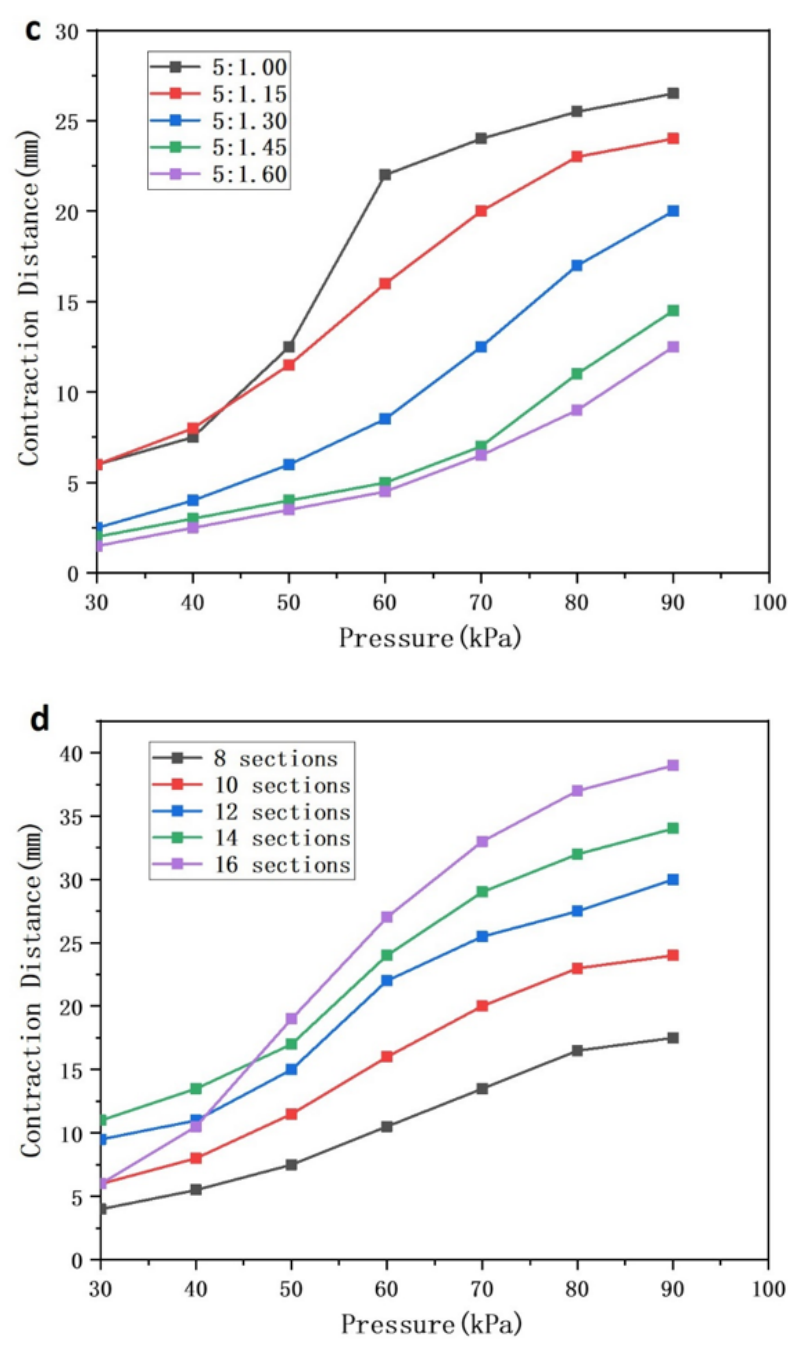
Figure 8. Experimental results from bending and contraction tests: ( a , b ) relationship between the bending angle and air pressure and ( c , d ) relationship between the contraction distance and air pres- sure.